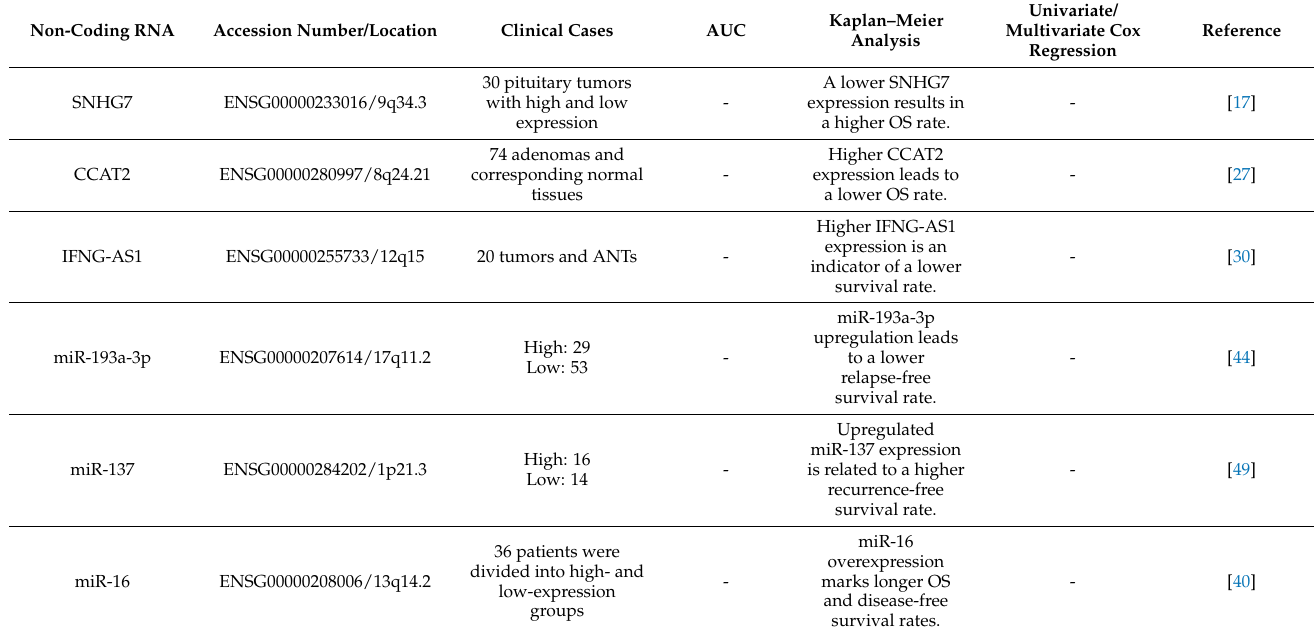
Table 4. Prognostic/diagnostic value of non-coding RNAs in pituitary gland tumors (OS: overall survival, ANTs: adjacent non-tumor